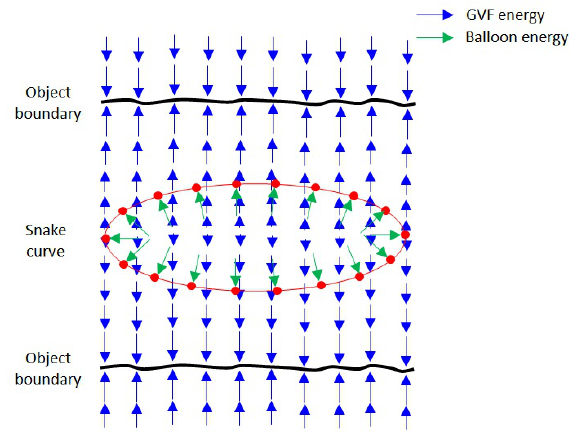
Figure 7. Balloon energy pushes the snake curve, and GVF energy attracts the snake curve toward the object